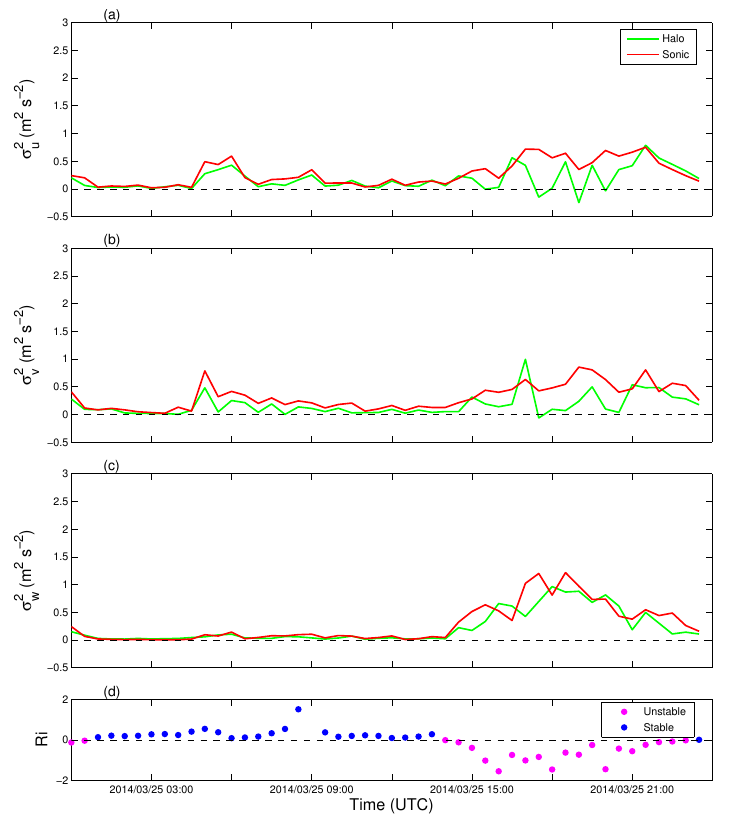
Figure 6. Thirty-minute (a) u variance, (b) v variance, and (c) w variance at 200m from sonic anemometers and Halo lidar six-beam technique at BAO and (d) Richardson number calculated from tower data. Data are shown from 25 March 2014. Note the high agreement between the six-beam Halo method and sonic in (c) as compared to the VAD Halo method in Fig. 5c for w variance. (The difference in vertical variance accuracy is also likely related to the different turbulent scales present at 100 and